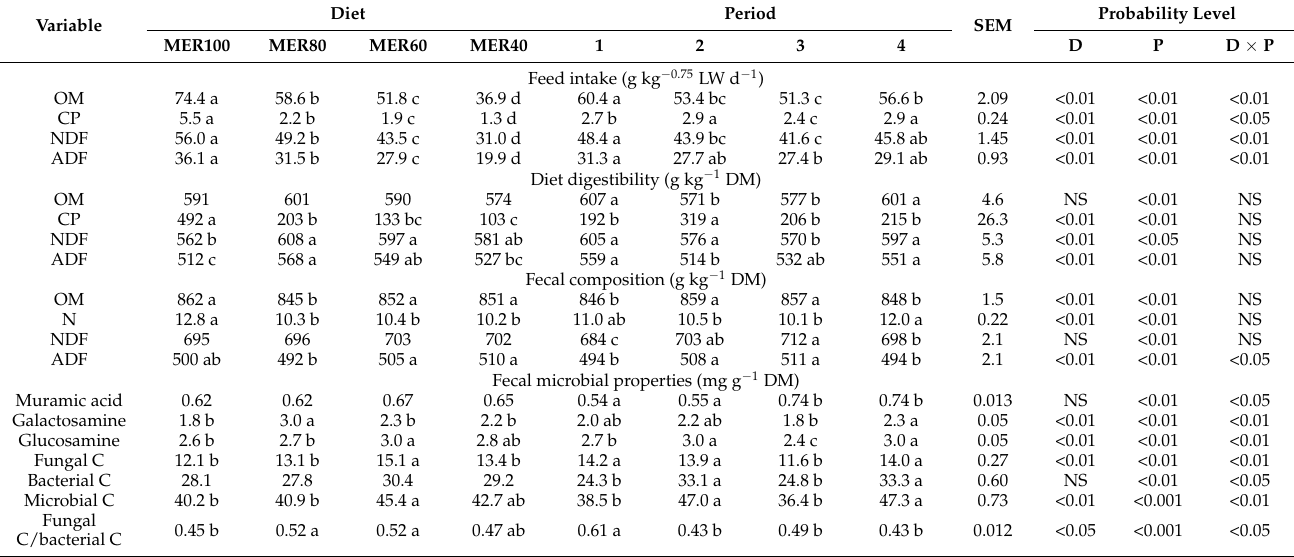
Table 2. Feed intake, diet digestibility and fecal concentrations of organic matter (OM), crude protein (CP) or N, neutral detergent fiber (NDF), and acid detergent fiber (ADF), as well as amino sugar components of fungal and bacterial biomass in feces of Boran steers fed diets corresponding to different levels (%) of maintenance energy requirements (MER); standard error of the mean (SEM); probability levels obtained with lme function.